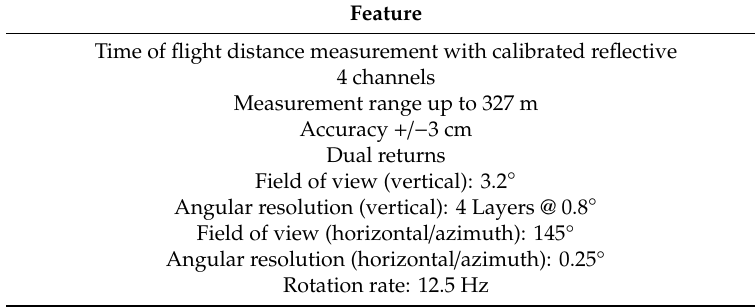
Table 3. 4 L LIDAR characteristics.